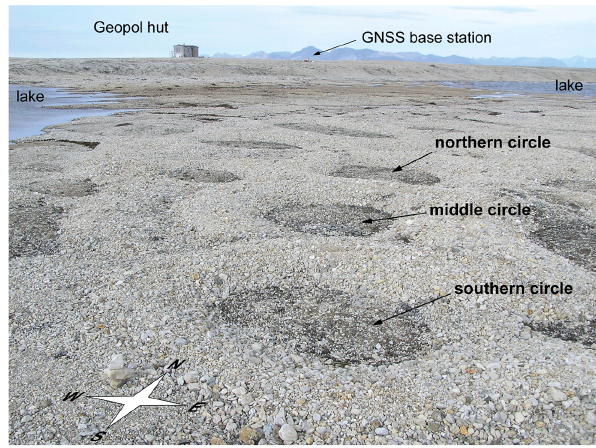
Figure 1. Photo of site and sorted circles studied. The darker, inner parts of the circles have a diameter of around 1.5m on average. View is to the north.